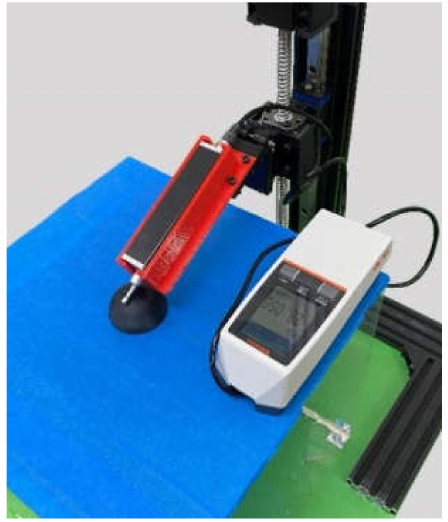
Figure 8. Measuring device